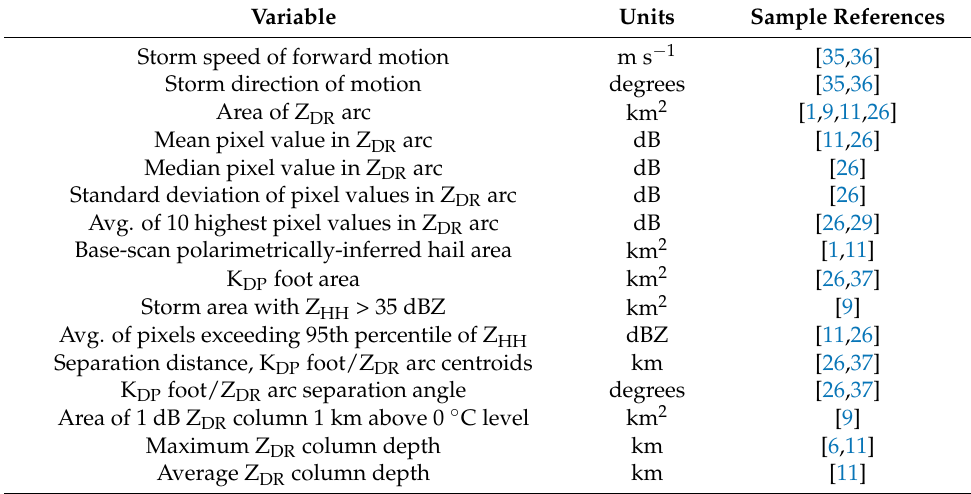
Table 3. SPORK output variables examined in this study and sample references describing